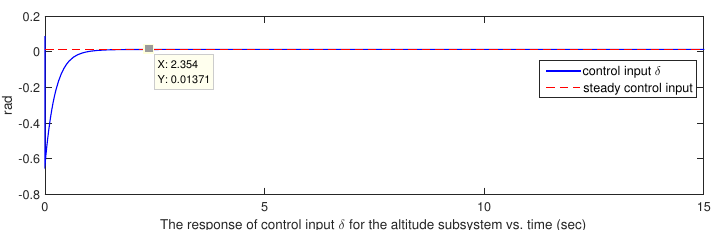
0 The response of control input δ for the altitude subsystem vs. time (sec) Figure 3. The control input response of the altitude subsystem.